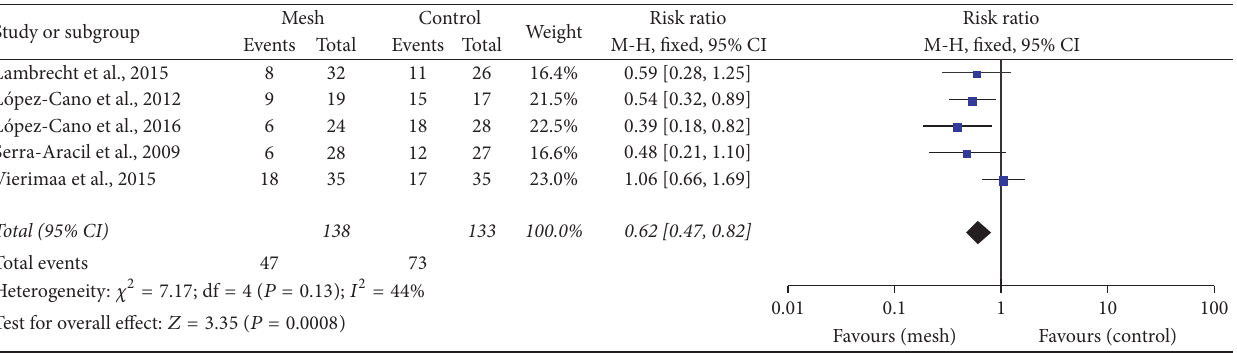
Figure 4: Forest plot for radiologically detected parastomal hernia.